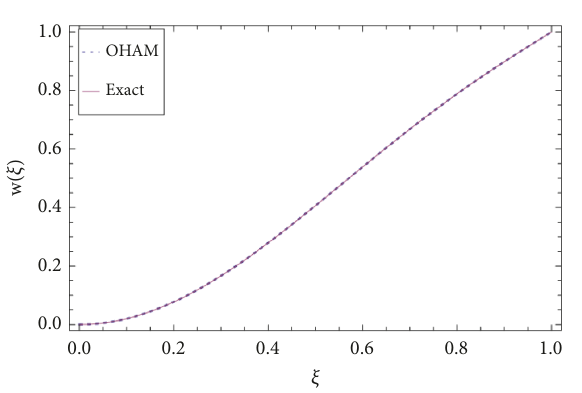
Figure 3: Comparison between exact solution (dashed line) and approximate solution (dotted line) for example